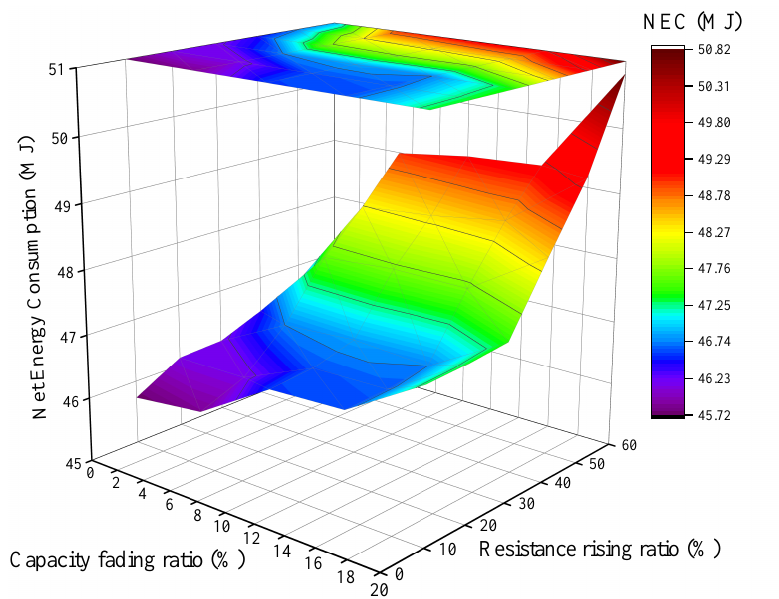
Figure 17. The NEC under varying capacity fading ratio and internal resistance rising ratio of Li-ion BATs.